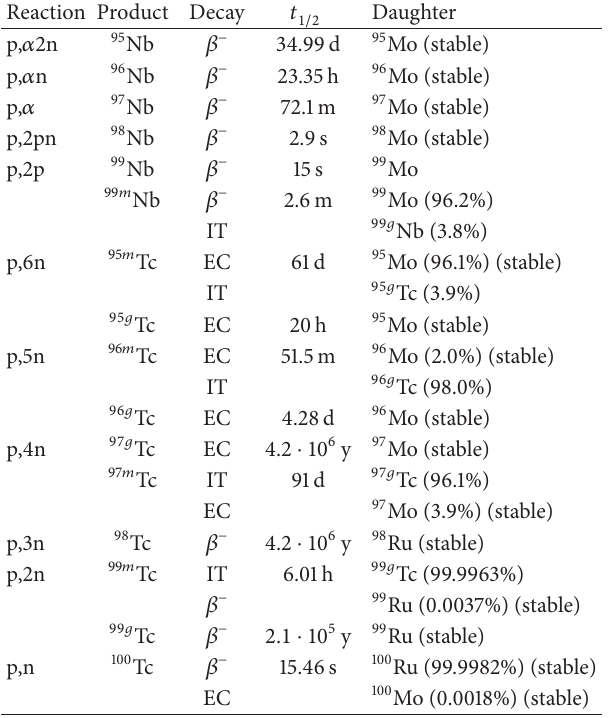
Figure2:Thecollectionof 100 Mo(p,pxn) 9𝑥 Motheoreticalexcitation functions from the TENDL 2012 library [24] up to the (p,p5n) level. The experimental measurements of 99 Mo by Levkovskij [2] and Takacs et al. [5] only are included for comparison. Table 1: Niobium and technetium isotopes expected to be produced by the 100 Mo(p, x ) reactions.